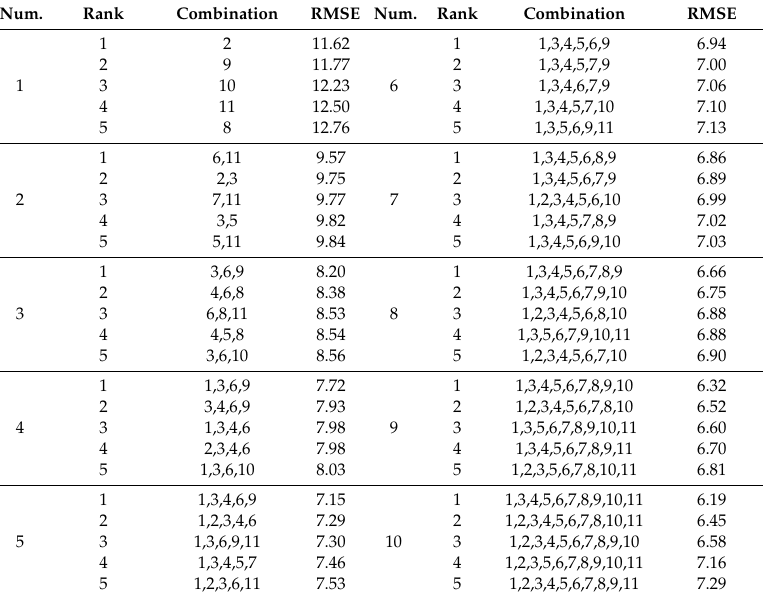
Table 4. The best of all combinations of